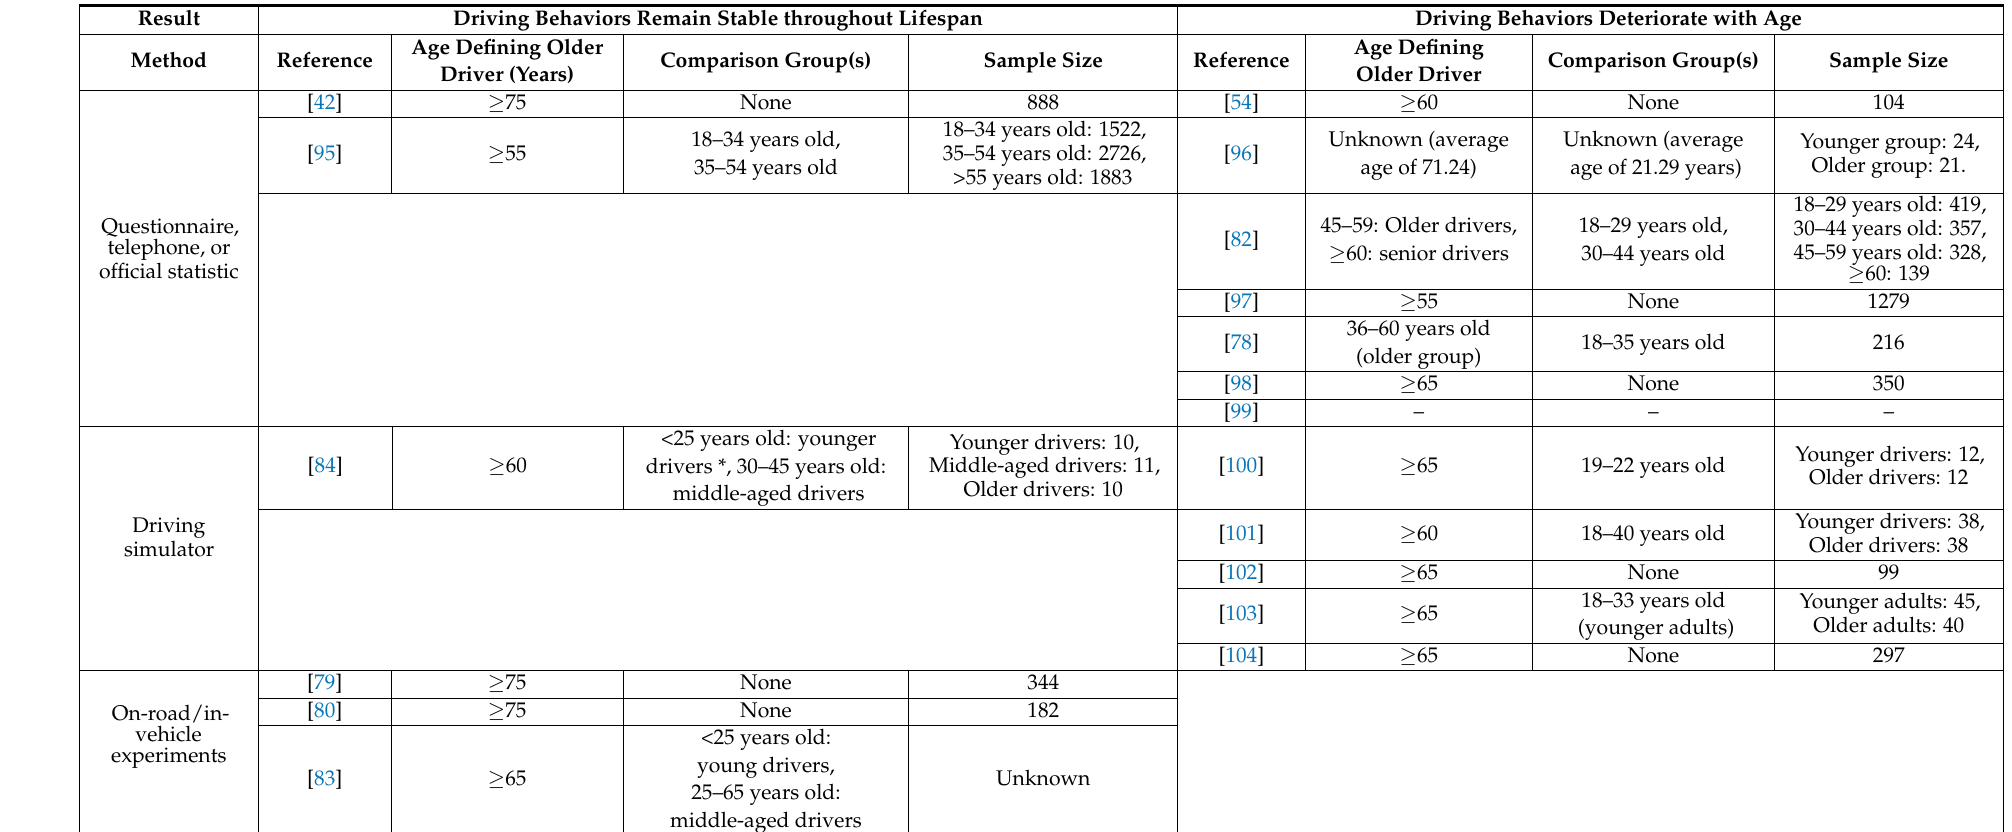
Table 3. Methods and results from studies on older drivers’